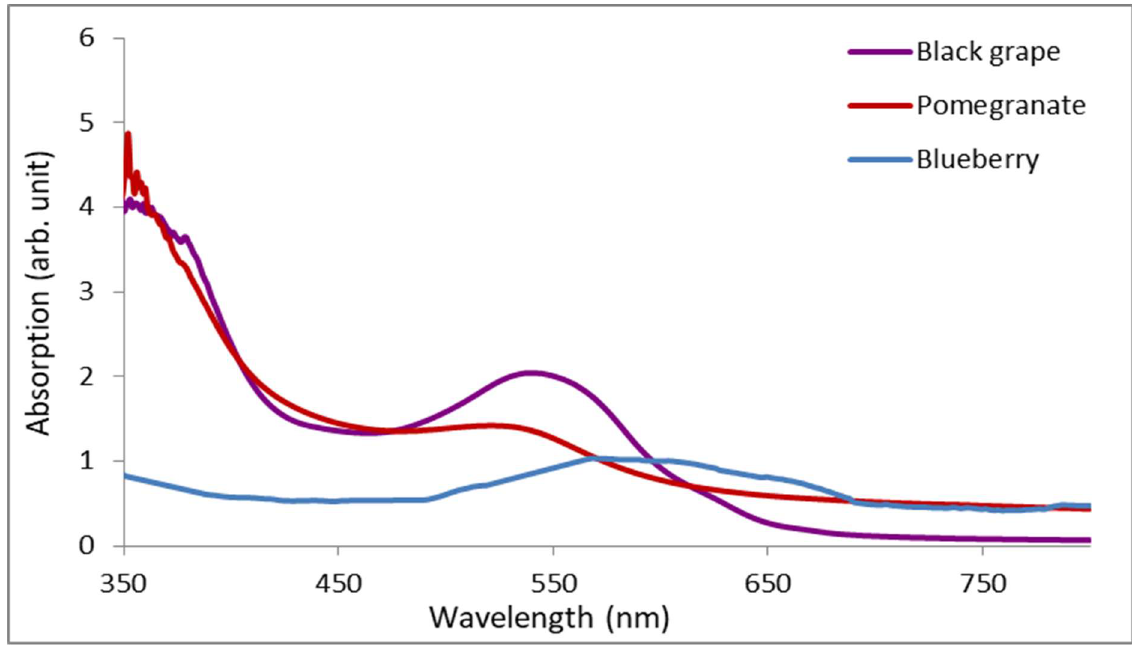
Figure 10. The absorption spectrum of anthocyanin fruit dyes.